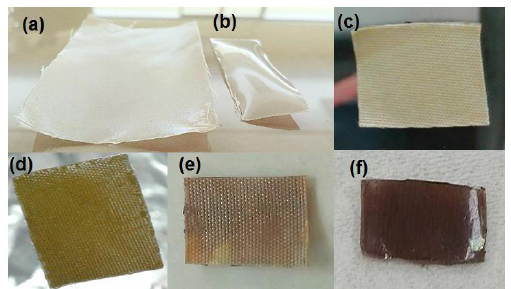
Figure 8. Images of PET fabrics grafted with hydrogels without silver nanoparticles (AgNPs) by ( a ) the photochemical method, ( b ) the gamma irradiation method; and photos of both sides of PET fabrics grafted with hydrogel and AgNPs by method: ( c , d ) Photochemical, back and front view, respectively, and ( e , f ) gamma irradiation, back and front view, respectively.